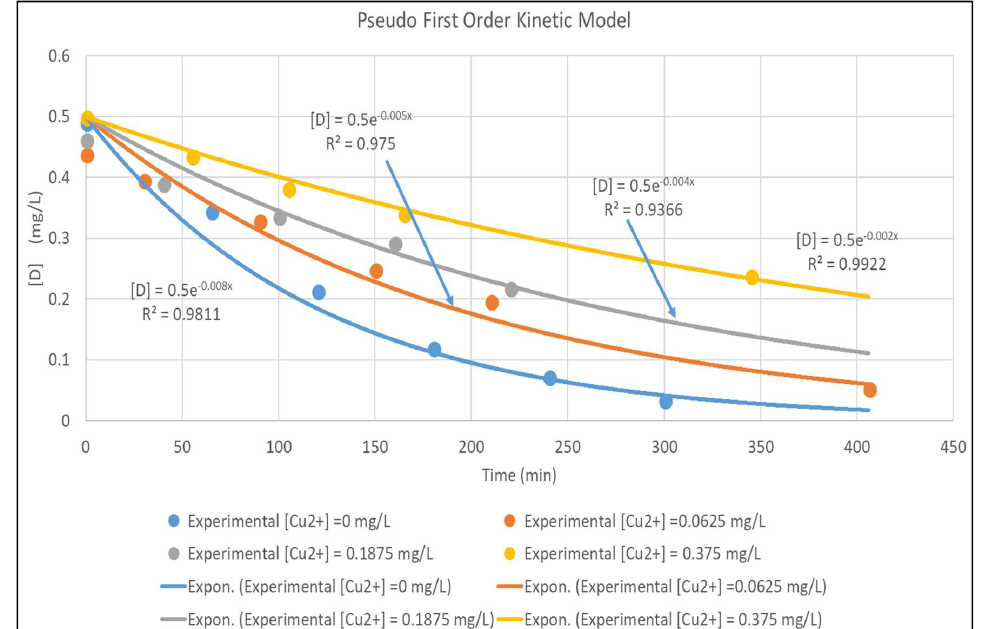
Figure 4. Pseudo First Order Fit for [Cu 2+ ] for [Cu 2+ ] 0–0.375 mg/L.